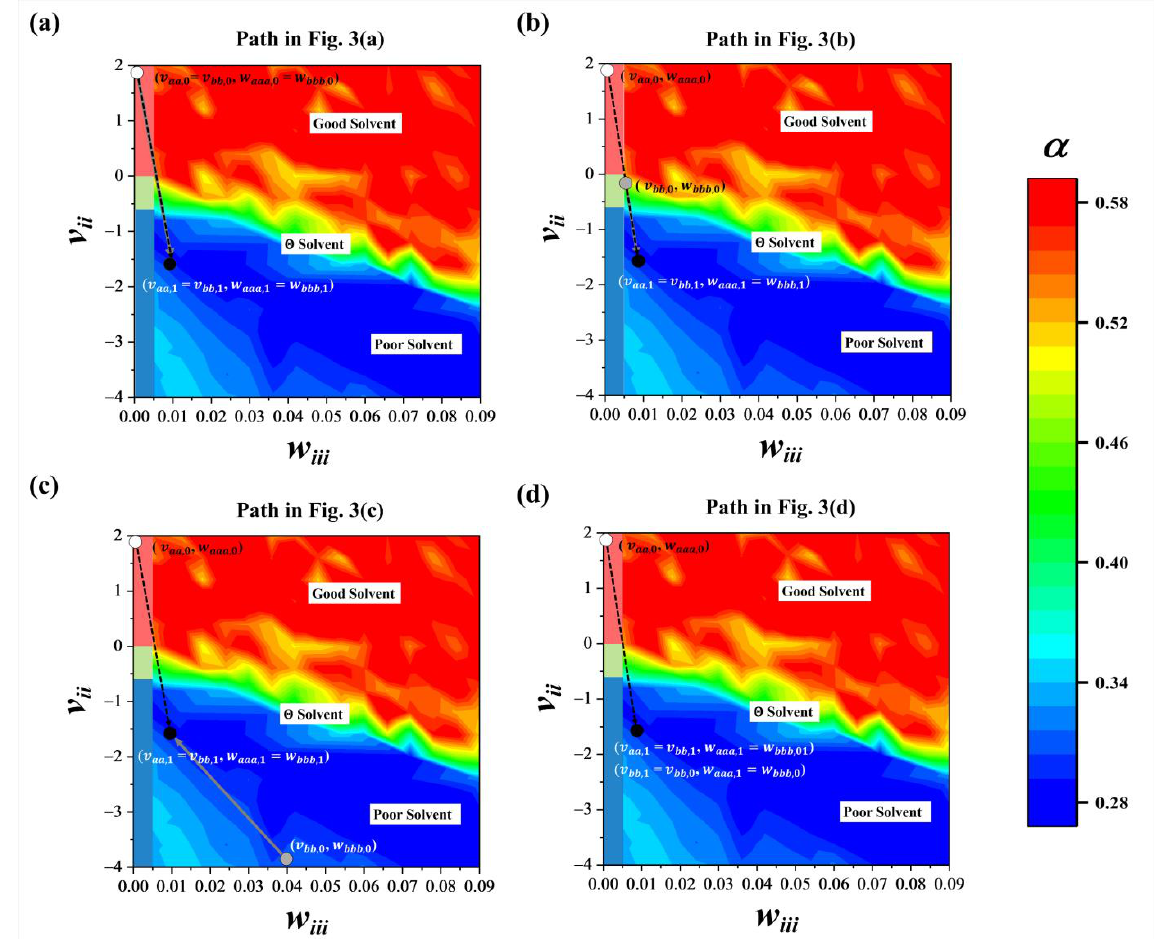
Figure 4. Trajectory of virial coefficients as a function of φ used in MC-G simulations of BCP solution assembly. Virial coefficients of A and B polymer species at a given polymer concentration φ , ( v aa, φ , w aaa, φ ) and ( v bb, φ , w bbb, φ ) used in MC-G simulations of AB BCPs dissolved in four different solvents are shown on the parametric color map of scaling exponent; ( a – d ) correspond to the trajectories of model parameters along φ used in simulations for Figure 3a–d in the main text. Trajectories of virial coefficients for each polymeric species are uniformly distributed on the black dashed line and gray solid line connecting virial coefficients of the same species in the dilute solution ( 0) and the melt state ( = 1). For Melt condition virial coefficients ( v aa,1 = v bb,1 , w aaa,1 = w bbb,1 ), which are same for all subfigures and for both species A and B are marked as block circles. The virial coefficients of A block in the dilute condition ( v aa,0 , w aaa,0 ), which are fixed over all sub- figures are marked as white circles. Location of coefficients of B block in the dilute condition ( v bb,0 , w bbb,0 ) presented as gray dots varies over subfigures as solvent quality to B varies. Black dashed and gray solid lines represent the trajectories of virial coefficients for A block and B block, respectively. Figure 3 presents the phase diagrams of each solvent condition. Observed phases of the sphere, cylinder, lamellae, bicontinuous, inverse cylinder, inverse sphere, and disor- dered are marked with red spheres, orange triangles, green diamonds, pink pentagons, blue inverse triangles, purple stars, and black squares, respectively. Order–disorder tran- sition (ODT) and order–order transition (OOT) are also schematically shown (black curves). The phases are distinguished by visual inspection of the observed morphologies from MC-G simulations. One could obtain more precise phase boundaries by conducting structures, or regions in which the lamella and cylinder phases coexist are not differenti- ated from one another; rather, all of these are marked as bicontinuous phases in Figure 3 (a few representative snapshots of bicontinuous phases are shown in Figure S4). Thus, the